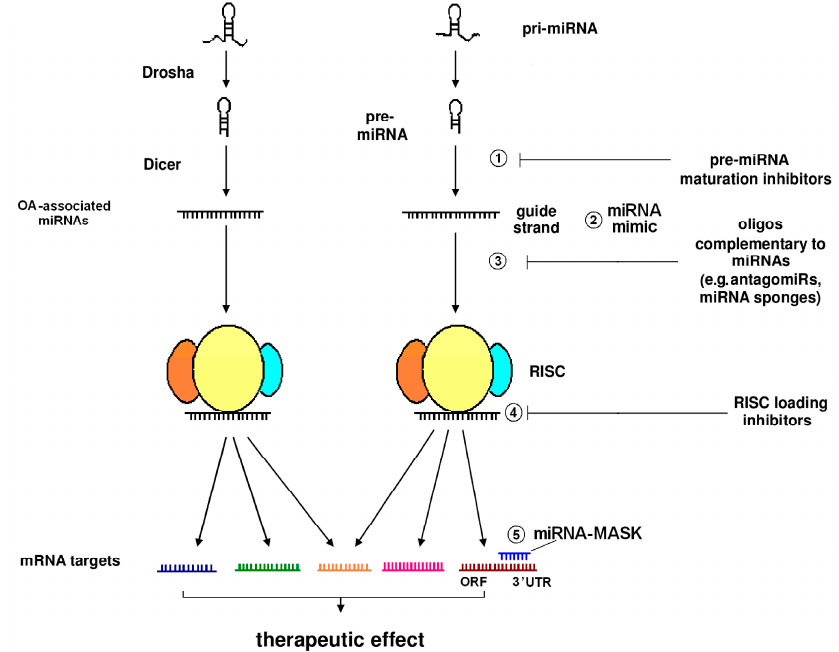
Figure 2. OA-associated miRNA-dependent pathways may be therapeutically targeted at multiple levels. Dicer-mediated processing of certain pre-miRNAs of the corresponding mature miRNA (guide strand) can be blocked via small molecules that serve as maturation inhibitors (level 1). miRNA mimics can be used to mimic the function of endogenous miRNA molecules (level 2). Oligonucleotides (oligos) complementary to miRNAs, such as antagomiRs and miRNA sponges, can interfere with miRNA:mRNA interactions through hybridization with target miRNAs (level 3). Chemically divergent small molecules, which block the assembly of RNA-induced silencing complex (RISC), designated as RISC loading inhibitors, have been also identified. These inhibitors do not affect argonaute 2 (Ago2) activity or pre-formed miRNA:Ago2 complexes (level 4). On the other hand, miRNA-masking (miRNA MASK) technology (level 5) involves the usage of single-stranded chemically modified oligos, which are complementary to the 3 (cid:48) untranslated region (UTR) of a target transcript. Therefore, the interaction among miRNA and its target is prevented, and the expression of a gene of interest is derepressed. Overall, the net result of all of the above-mentioned putative therapeutic strategies is the modulation of the expression of different mRNAs that are associated with OA pathogenesis. Note that a miRNA may regulate multiple miRNA targets, while a distinct mRNA may be controlled by more than one miRNA. This phenomenon contributes to the generation of a complicated network of interplaying pathways. ORF: open reading frame; pri-miRNA: primary